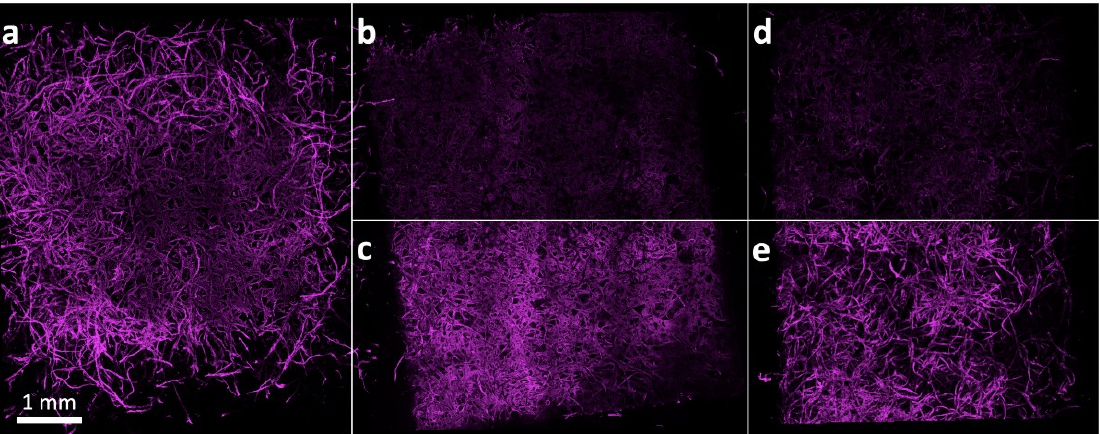
Figure 5. CLSM image of three differently treated cotton linter papers, stained with CBM3a-mRuby3: uncoated ( a ), coated with POEGMA ( b , c ), and coated with PDMAA ( d , e ). The bottom half of the POEGMA ( c ) and PDMAA ( e ) coated papers is enhanced in brightness for better visualization, while the top half shows the observed intensity in comparison to the uncoated paper.